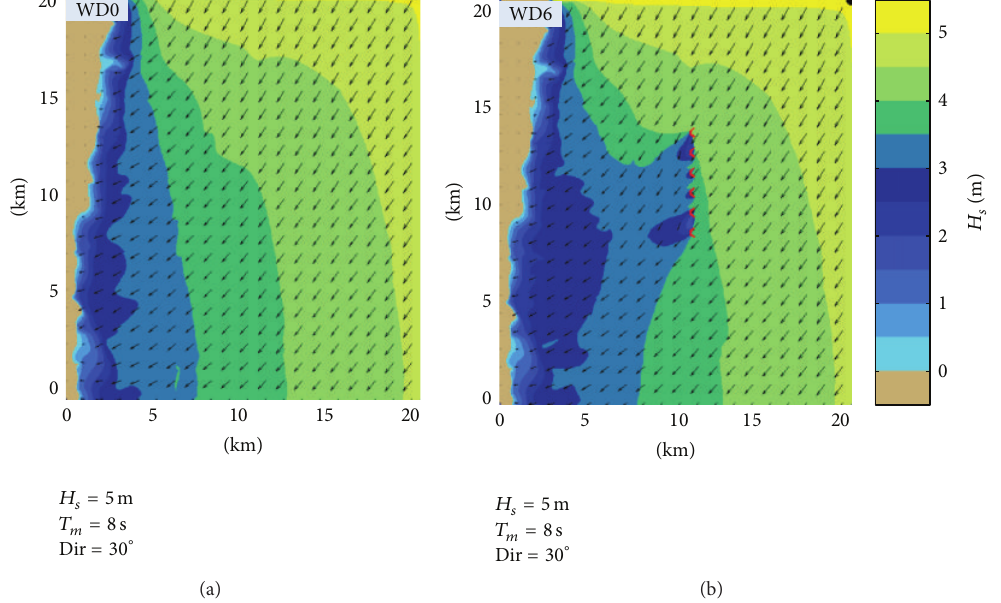
Figure 15: 𝐻 𝑠 variation along the reference line 3 without and with WD farm (WD0, WD6) for the two cases considered (CS1, CS2) and the variation of the water depth along the reference